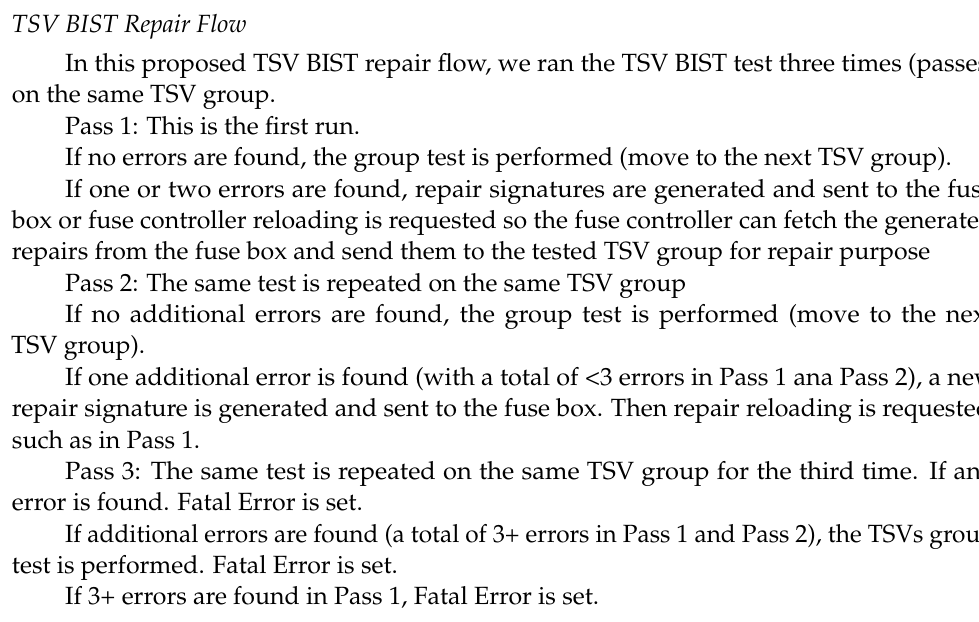
Figure 12. Repair MUX structure.